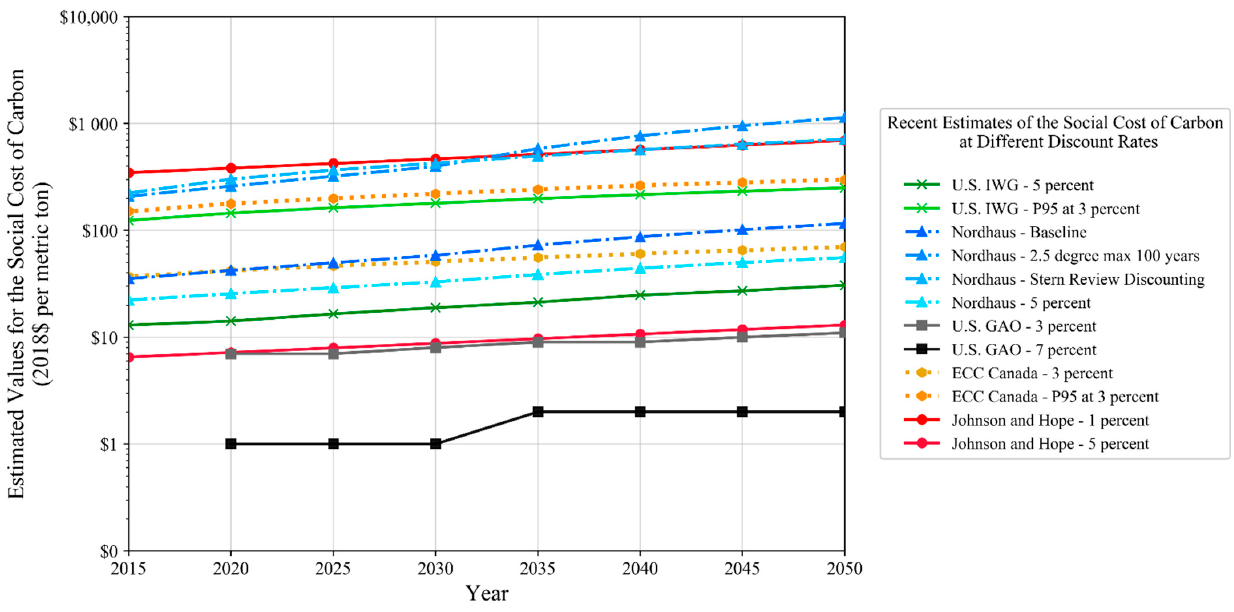
Figure 4. Compilation of estimates of the SCC (in 2018$ USD/tCO 2 ) from literature. Estimated values are measured in 2018$ and during span years 2015–2050. Table 1. Recent estimates of the